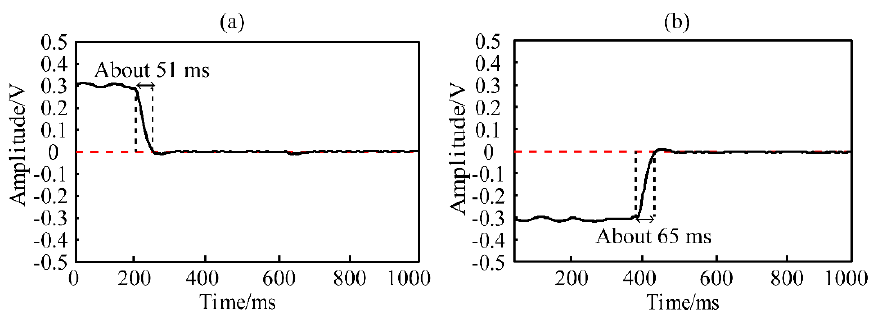
Figure 6. The result of the phase fading compensation via the feedback control scheme when the initial phase di ff erence is located at ( a ) [ − π /2, π /2 ) and ( b ) [ π /2,3 π /2 ) .